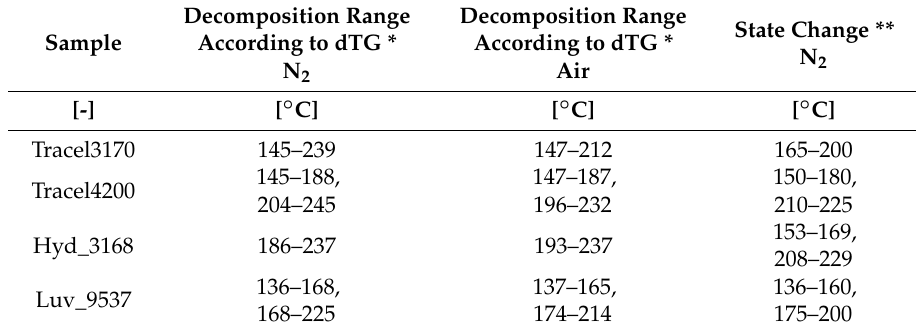
Table 4. Comparison of decomposition processes registered with DSC and TGA tests.